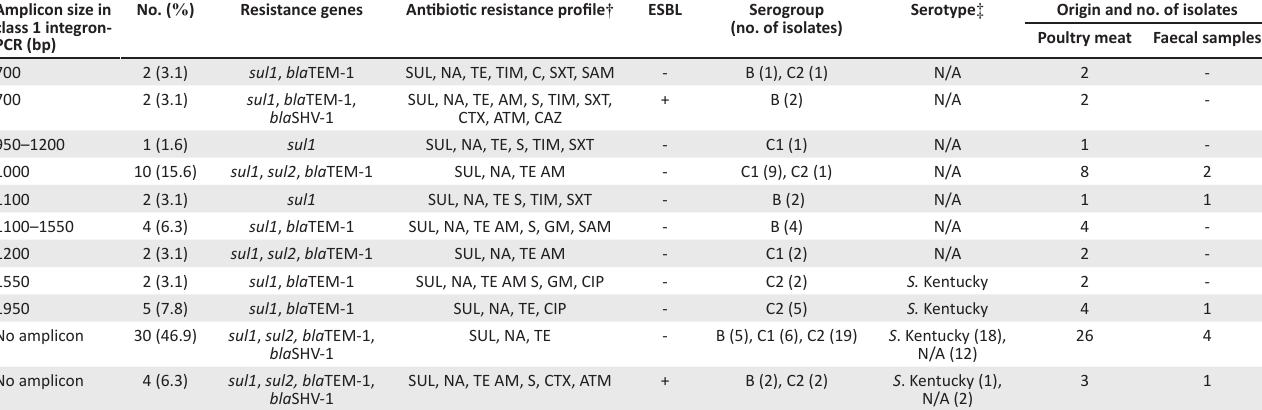
TABLE 5: Characteristics of class 1 integron-carrying multidrug-resistant S. enterica strains isolated from poultry meat and faecal samples ( n = 64). Amplicon size in class 1